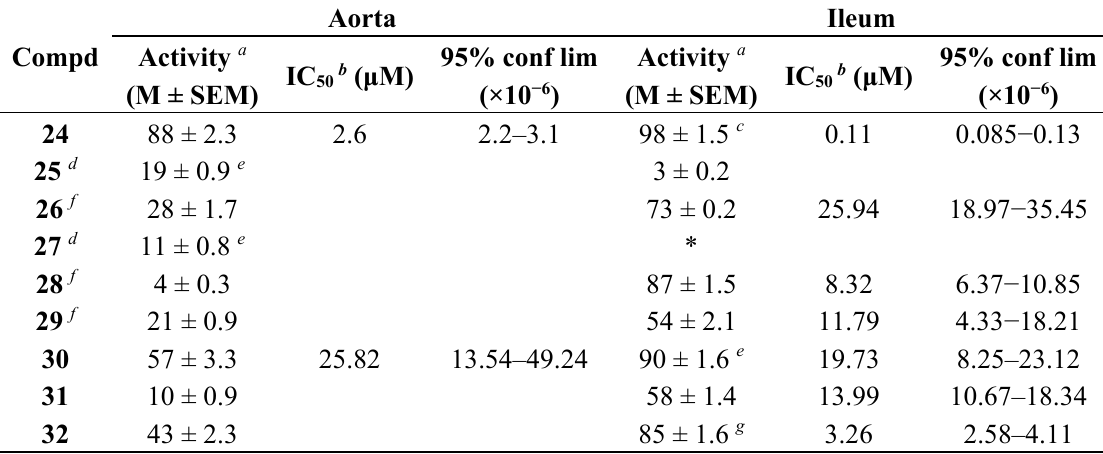
Table 2. Relaxant activity of compounds 24 – 40 on K + -depolarized guinea pig vascular and nonvascular smooth